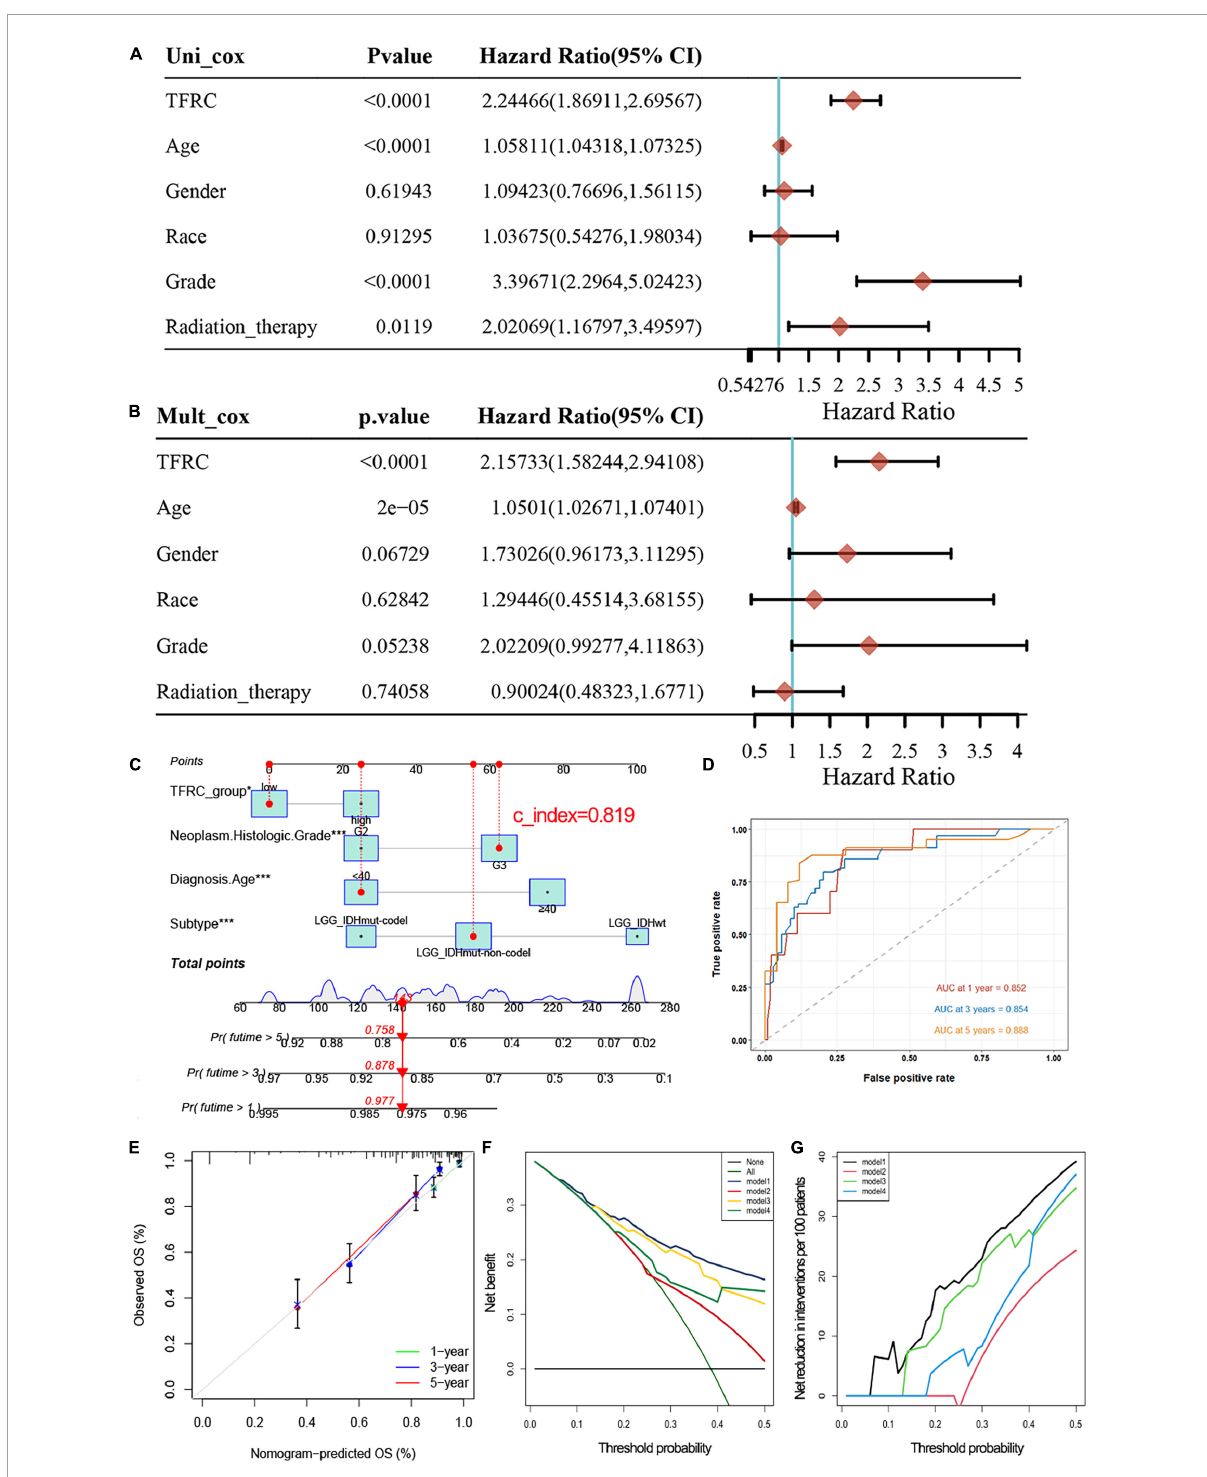
FIGURE3 Univariate and multivariate Cox regression analysis in LGG and nomogram predicting. (A) Univariate Cox regression. (B) Multivariate Cox regression. (C) Nomogram predicting probability in LGG. TFRC and 3 clinicopathologic factors are located on each variable axis. The sum of these numbers is located on the Total Points axis, and the three lines are drawn downward to the 1, 3, 5-year survival probability of LGG axes to determine the probability. (D,E) The ROC curve showed the area under curve (AUC) values and the nomogram prediction calibration curve. (F,G) Decision curve analyses demonstrating the benefit for predicting survival, model 1: TFRC group, Diagnosis Age, Histologic Grade, and Subtype. Model 2: TFRC group. Model 3: TFRC group, Histologic Grade, Subtype. Model 4: TFRC group, Subtype. * p < 0.05, ** p < 0.01, and *** p <